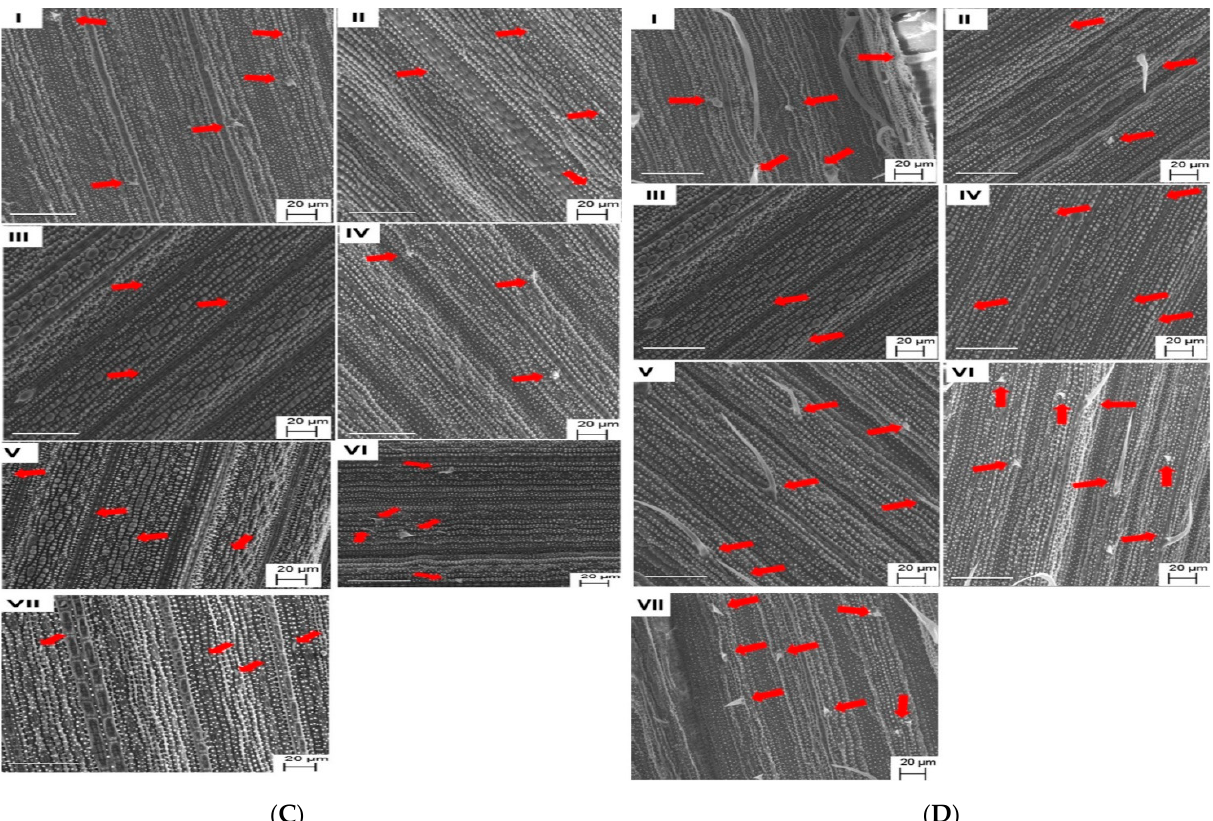
Figure 8. Impact of ZnO-NPs on stomata (( A ) Kargi, ( B ) CSR 30) and trichome morphology (( C ) Kargi, ( D ) CSR 30). Subfigures represent different treatments with ZnO-NPs: ( I )—control, ( II )—60 mM NaCl, ( III )—80 mM NaCl, ( IV )—100 mM NaCl, ( V )—60 mM NaCl + ZnO-NPs (50 mg/L), ( VI )—80 mM NaCl + ZnO-NPs (50 mg/L), and ( VII )—100 mM NaCl + ZnO-NPs (50 mg/L); red arrows indicate trichomes and stomata.